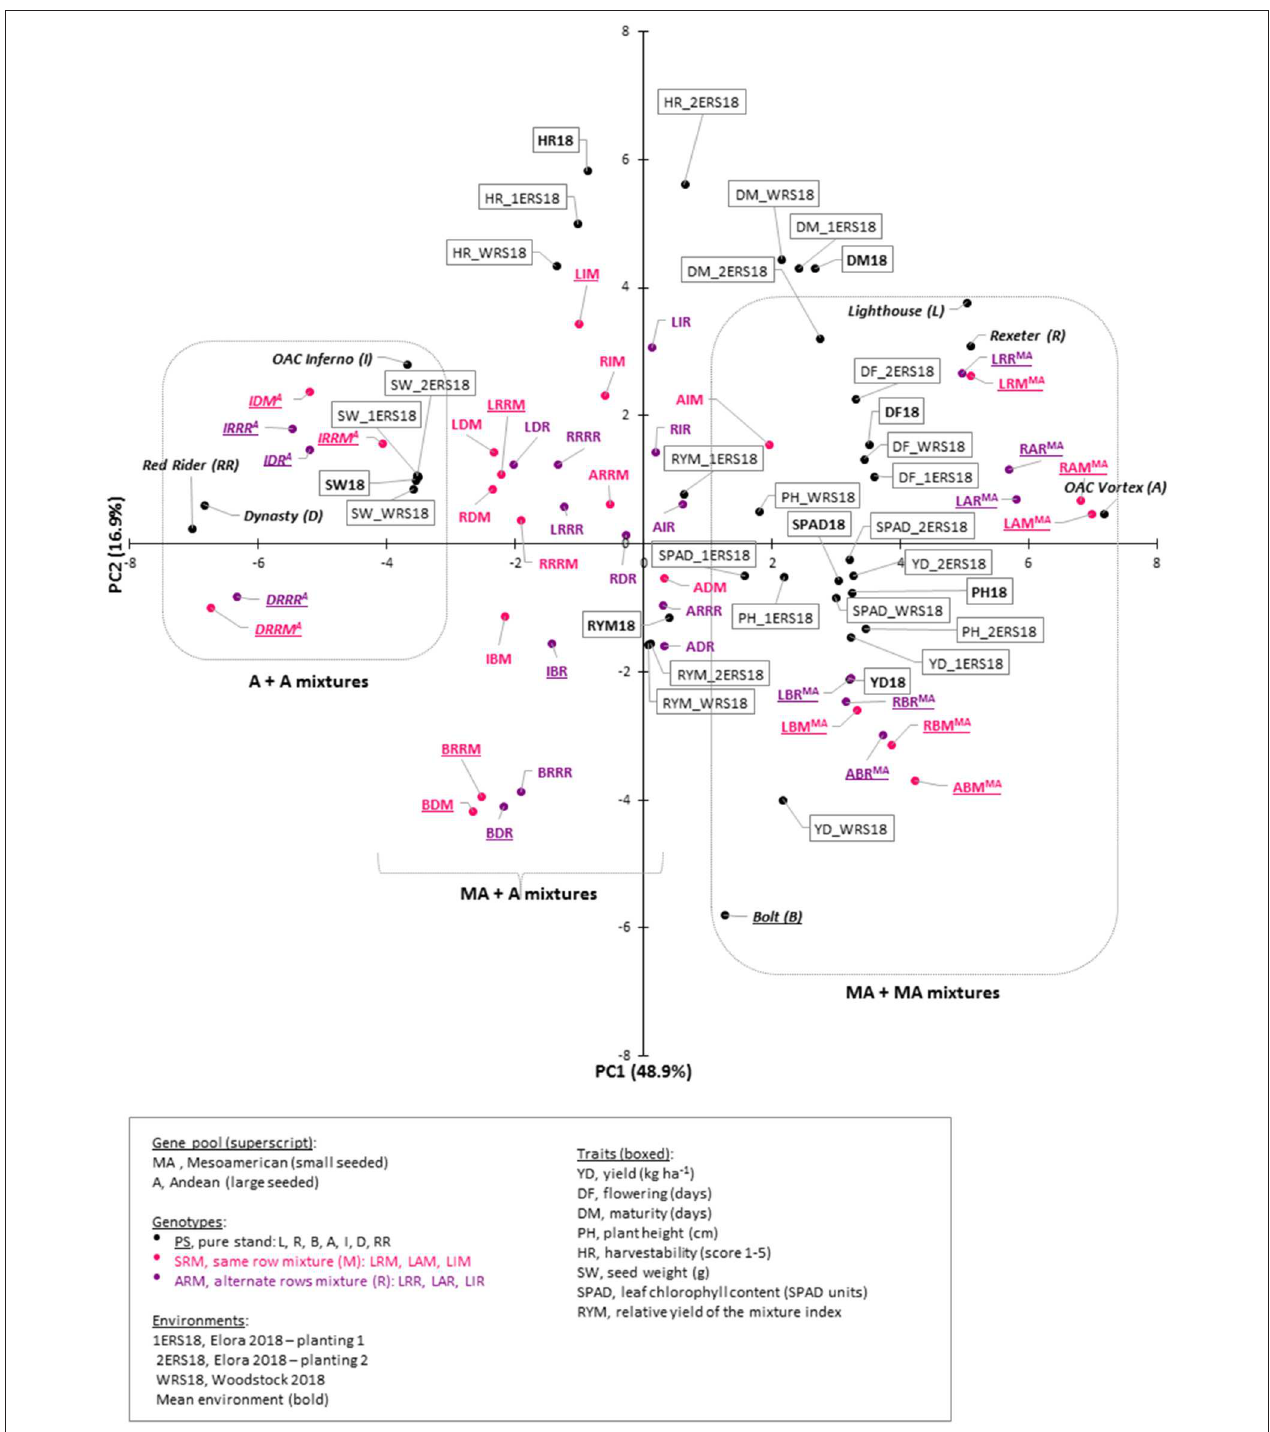
FIGURE 5 | Genotype-trait (GT) biplot analysis for seven common bean genotypes and their mixtures in three Ontario environments/locations in 2018. Cumulatively, first two principal components (PC) explained 65.8% variability. Genotypes separation into Andean (A, left), Mesoamerican (MA, right) and combined (MA + A, middle) is indicated. Traits: yield (YD, kg ha − 1 ), relative yield of the mixture (RYM) index, flowering (DF, days), maturity (DM, days), plant height (PH, cm), harvestability (HR, scale 1 to 5), seed weight (SW, g) and leaf chlorophyll content (SPAD, SPAD values). Environments/locations: mean environment [trait symbol with a year (e.g.